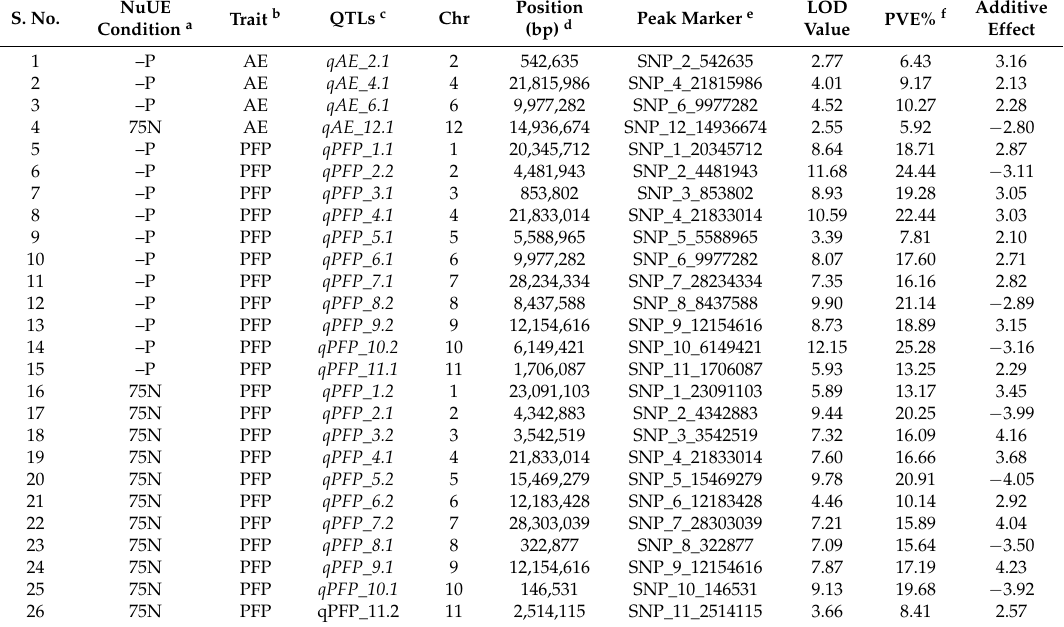
Table 6. Putative QTLs identified for AE and PFP for six different nutrient conditions using 230 nutrient use efficient